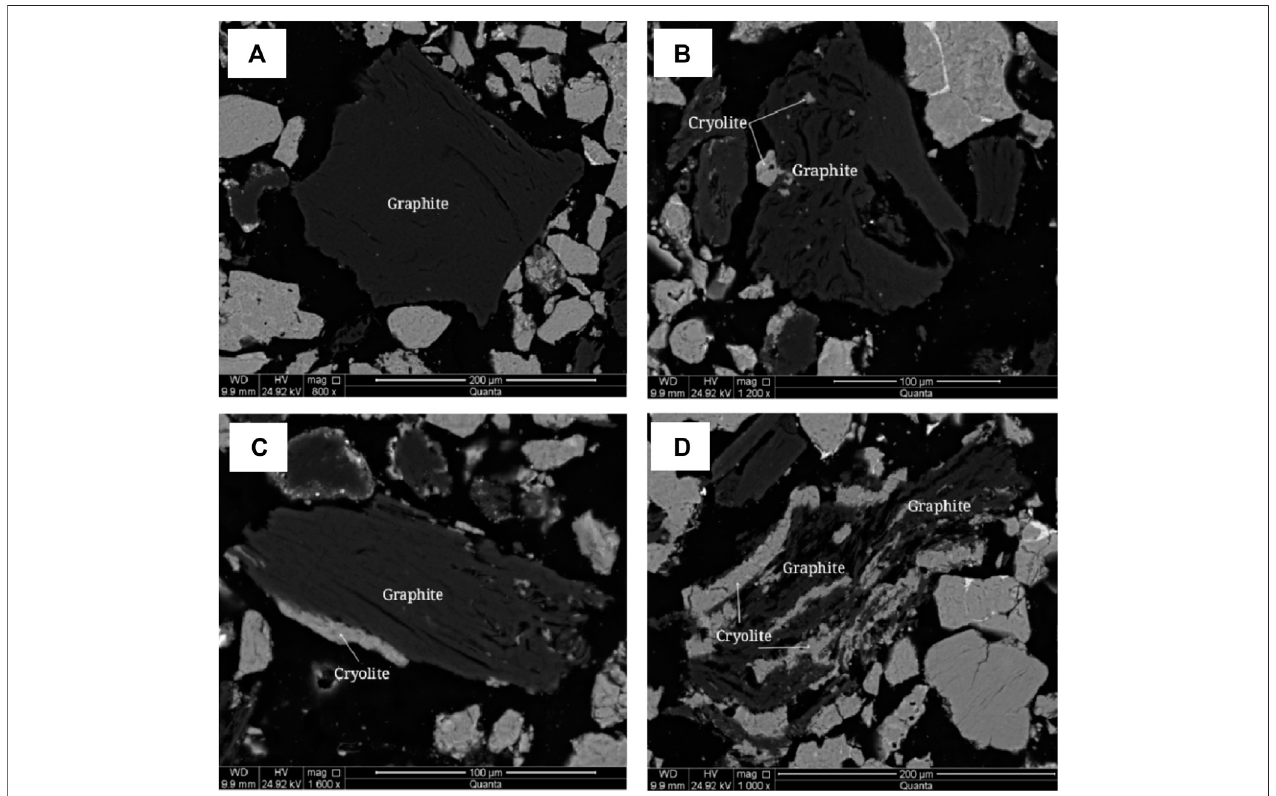
FIGURE10| Scanningelectronmicroscopebackscatteredelectronimageofgraphite. (A) Graphitedissociatedfrommonomers. (B) Graphitebondedtocryoliteor encapsulated with fi ne grained cryolite. (C) Graphite bonded with cryolite. (D) Cryolite is distributed in